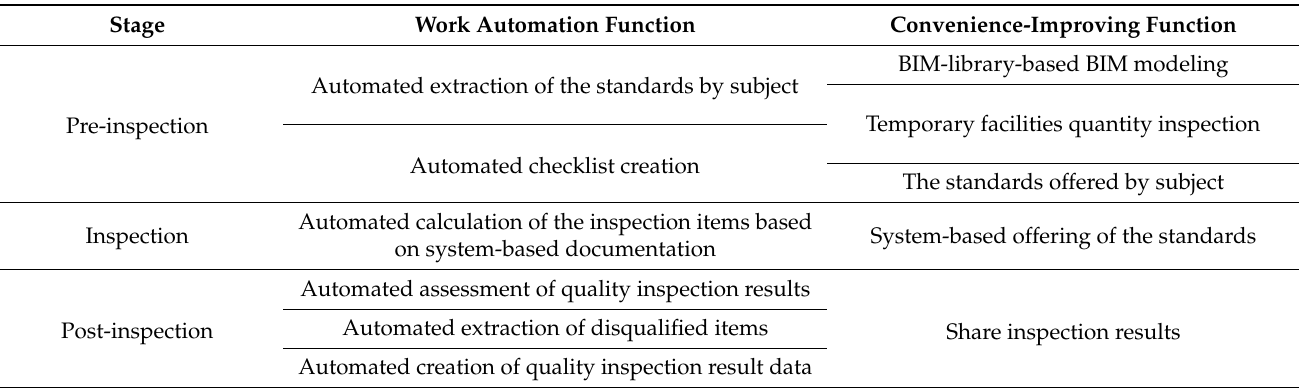
Table 4. System prototype function